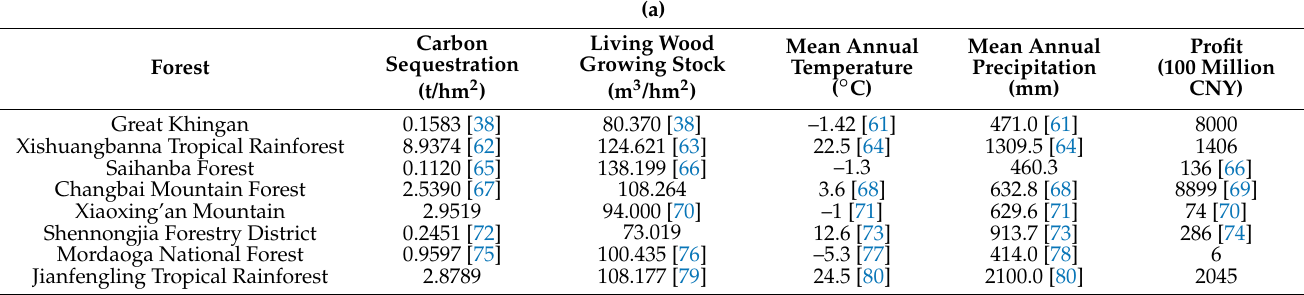
Table A1. Data of ten indicators of eight